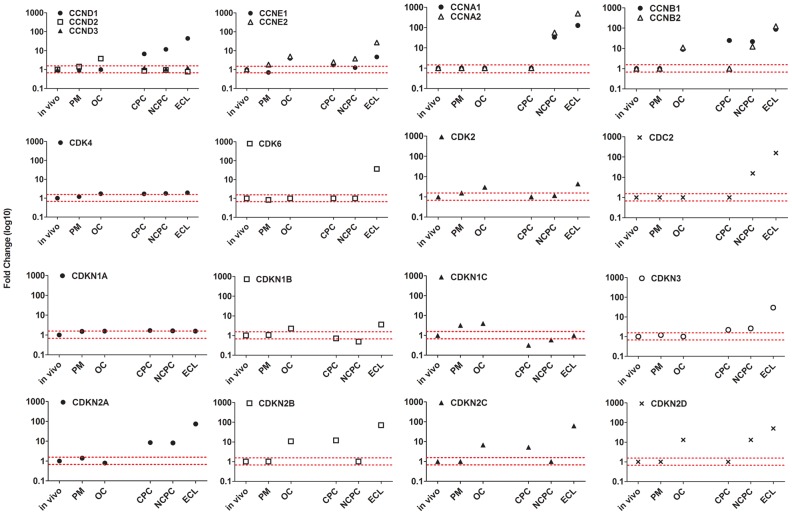
Analysis of mRNA expression of cyclins, CDKs and CKIs in endothelial cells exposed to 6 different environments.Fold-change expressions of in vivo (reference), post mortem (PM), organ culture (OC), confluent primary culture (CPC), non-confluent primary culture (NCPC), and endothelial cell line (ECL) models were represented in logarithmic scale. The red dotted lines show limits of under/overexpression (fold-change ≥1.5).